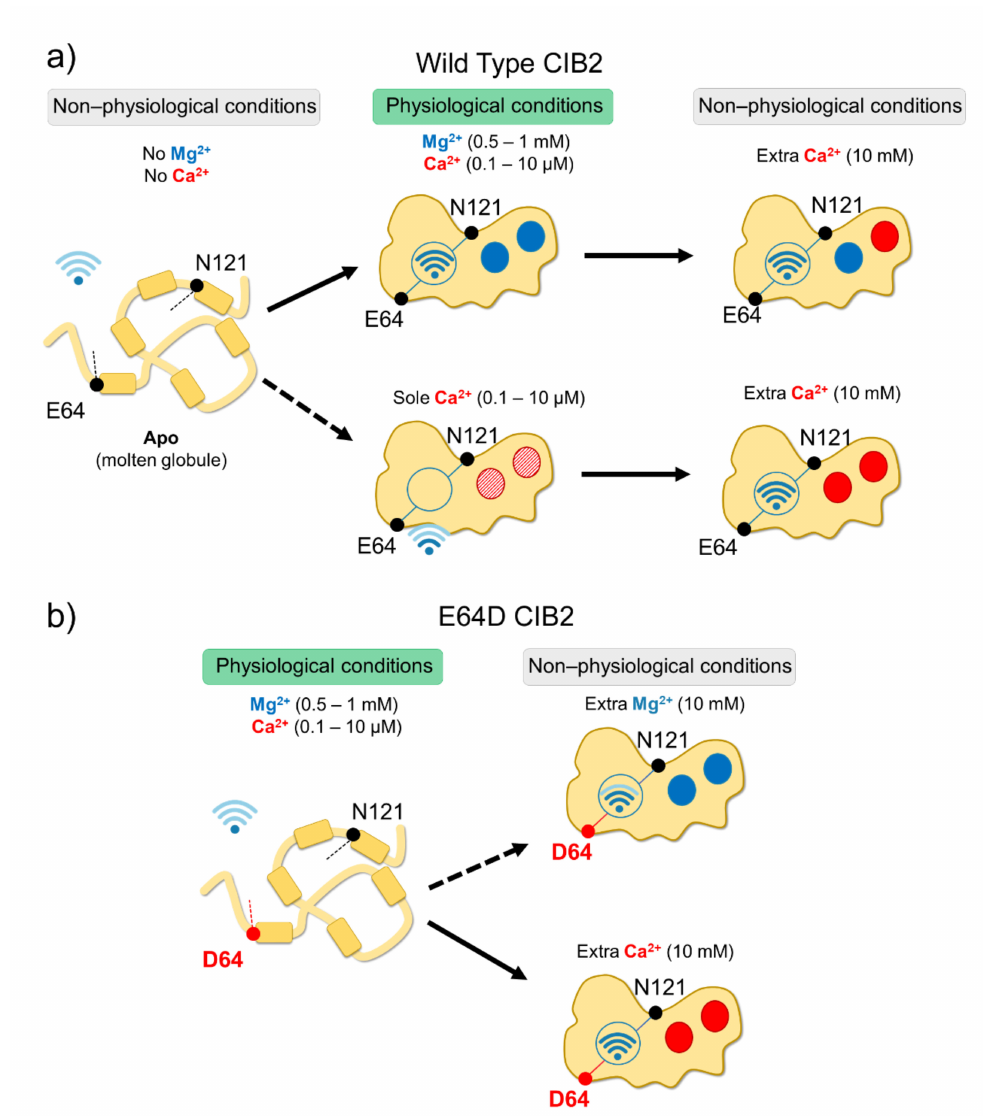
Figure 2. Schematic representation of CIB2 cation sensitivity and structural transitions. ( a ) In the absence of cations, WT CIB2 is in a molten globule state (left). The addition of a physiological concentration of both Mg 2+ and Ca 2+ (middle top panel) triggers the binding of Mg 2+ in EF3 and EF4. In the presence of physiological Ca 2+ and absence of Mg 2+ (middle bottom panel), Ca 2+ binding is less favorable. When extra (non-physiological) Ca 2+ concentrations are added, Ca 2+ replaces Mg 2+ in EF4 (upper right panel). ( b ) E64D CIB2 is in a molten globule state under physiological conditions (left). A well-defined three-dimensional structure is acquired upon the addition of extra (non-physiological) Mg 2+ (upper right panel) or Ca 2+ (bottom right panel), with a more pronounced effect for Ca 2+ . The Wi-Fi logo represents the strength of allosteric interactions between E64 and N121